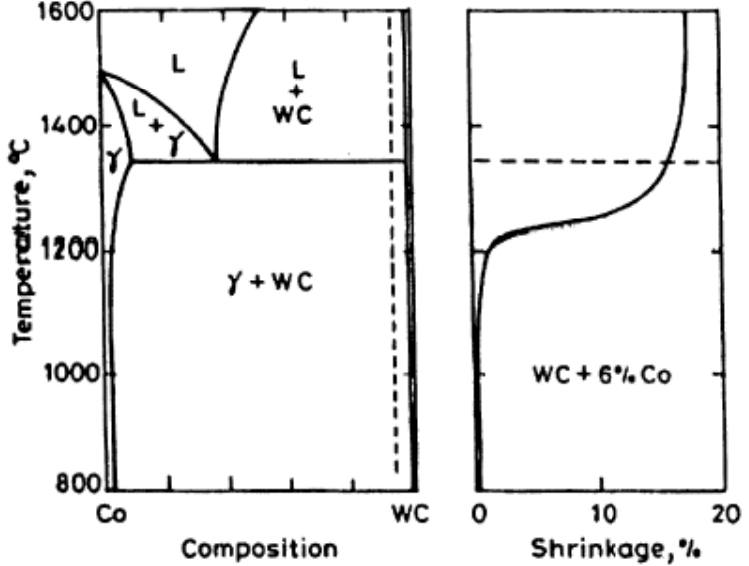
Figure 1. WC-Co pseudo-binary diagram (left side) and shrinkage during the WC-6Co sintering phase (right side) [5].